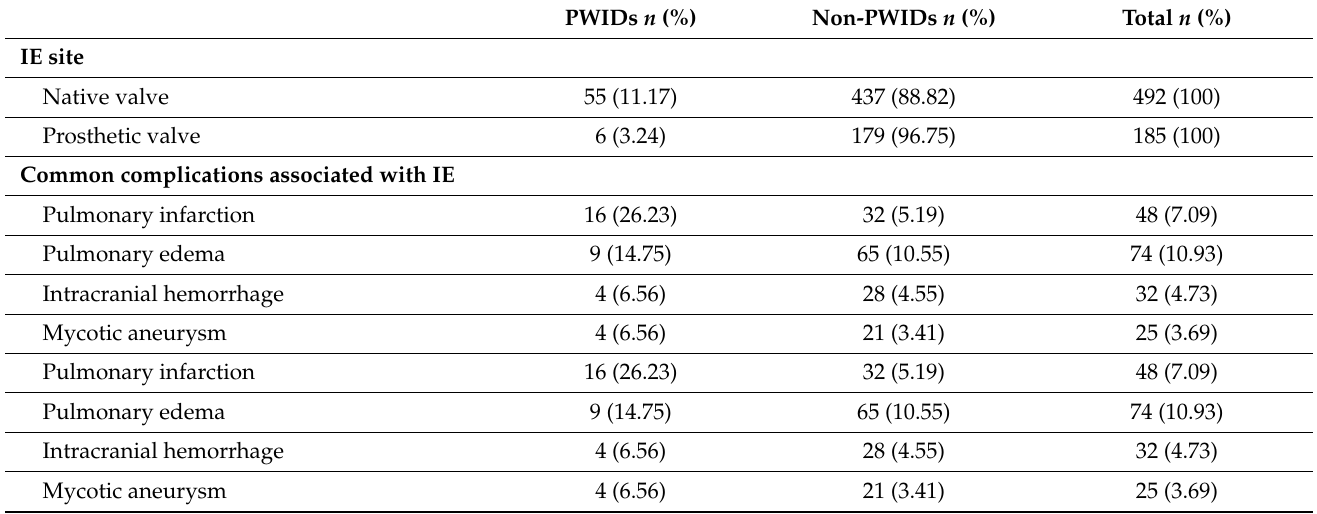
Table 3. IE site and